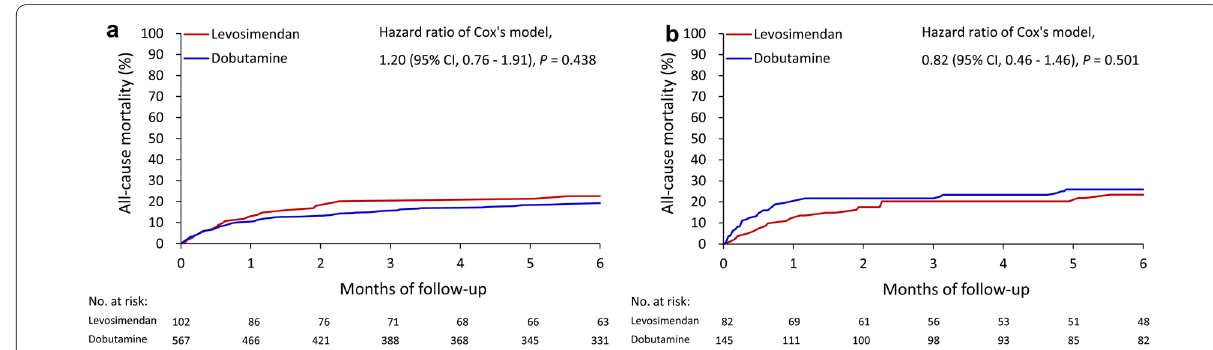
Fig. 2 All‑cause mortality of the patients with eGFR after ( b ) propensity score